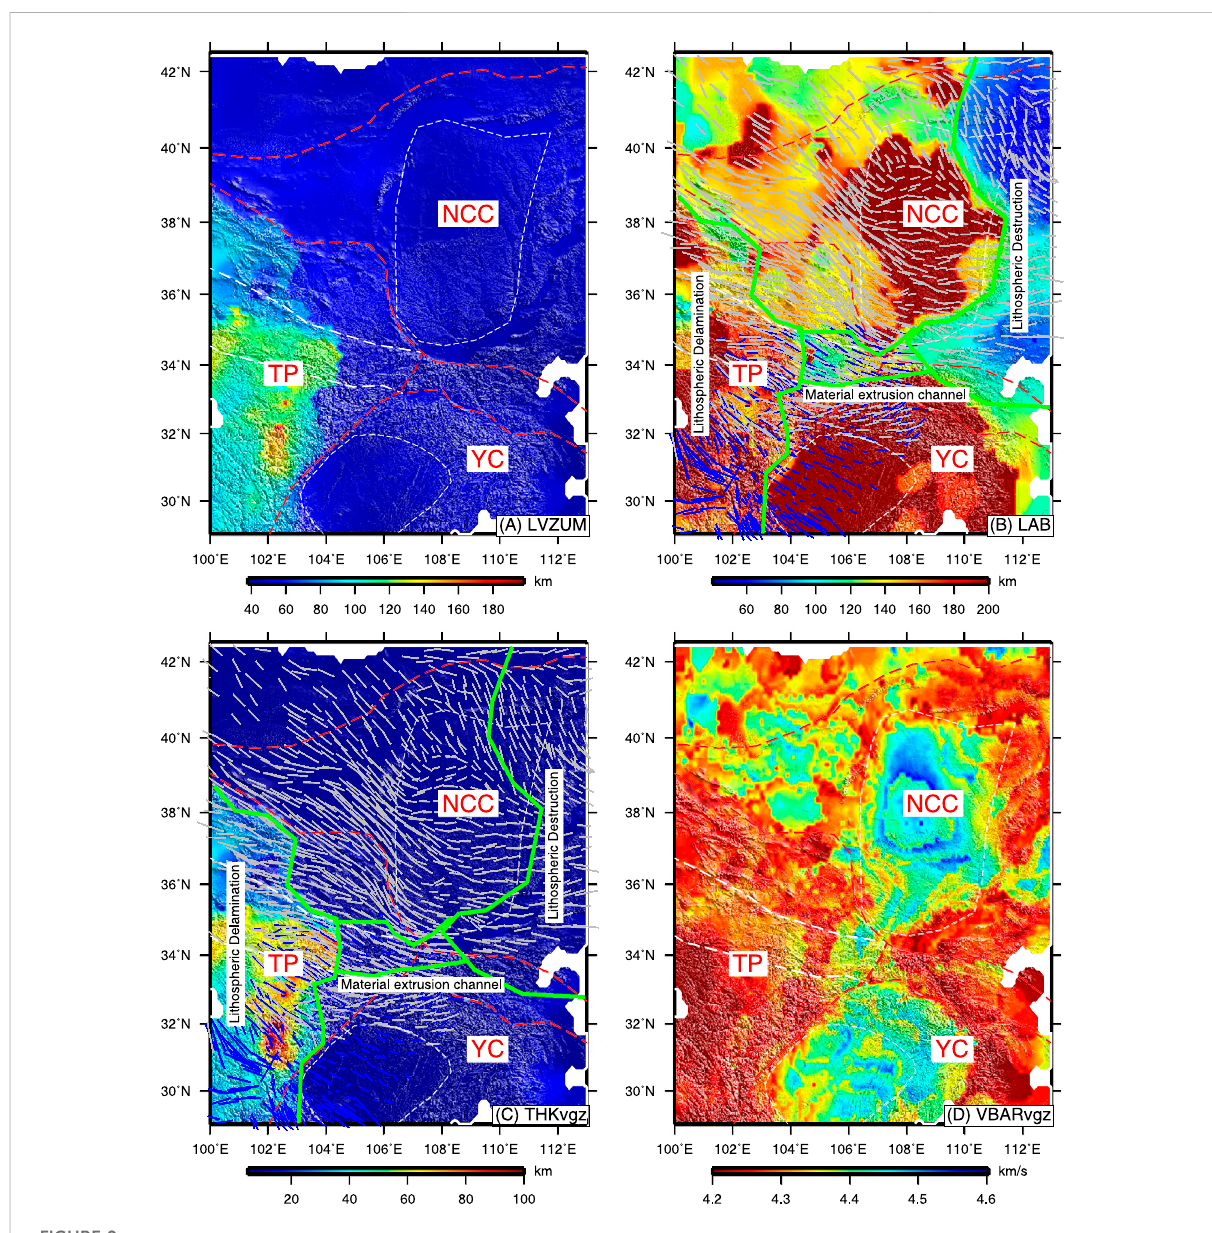
FIGURE 9 (A) The bottom of LVZ in the uppermost mantle: Search for Vs*=4.35 km/s from Moho; (B) Lithosphere-asthenosphere boundary: Search for Vs*=4.35 km/s from the Moho downwards and extrema in negative velocity gradient zones, and note that the dark red (200 km) in the fi gure indicates that the corresponding boundary is not found; (C) Thickness of the velocity gradient zone (VGZ) at the uppermost of the mantle lithosphere; (D) the average velocity of the VGZ. Blue lines and gray lines represent the SKS wave splitting results from Liu et al. (2020), Liu et al. (2021); Chang et al., 2017; Chang et al., 2021). The green lines indicate the regional scopes of lithospheric delamination, hot material extrusion channel and lithospheric